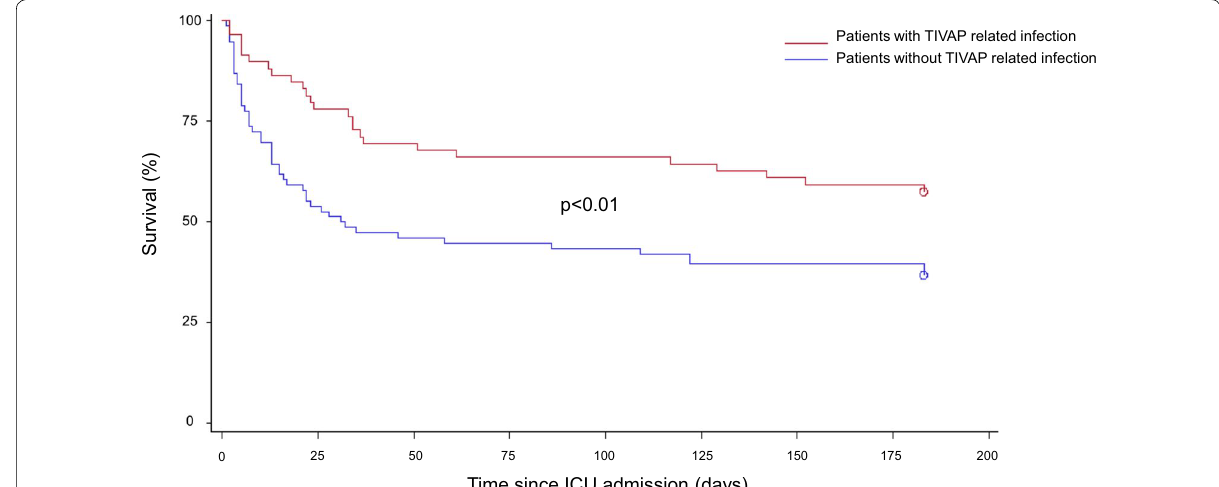
Fig. 1 Kaplan–Meier survival curve with 6-month mortality in patients with and without totally implanted venous access port (TIVAP)-related infec-